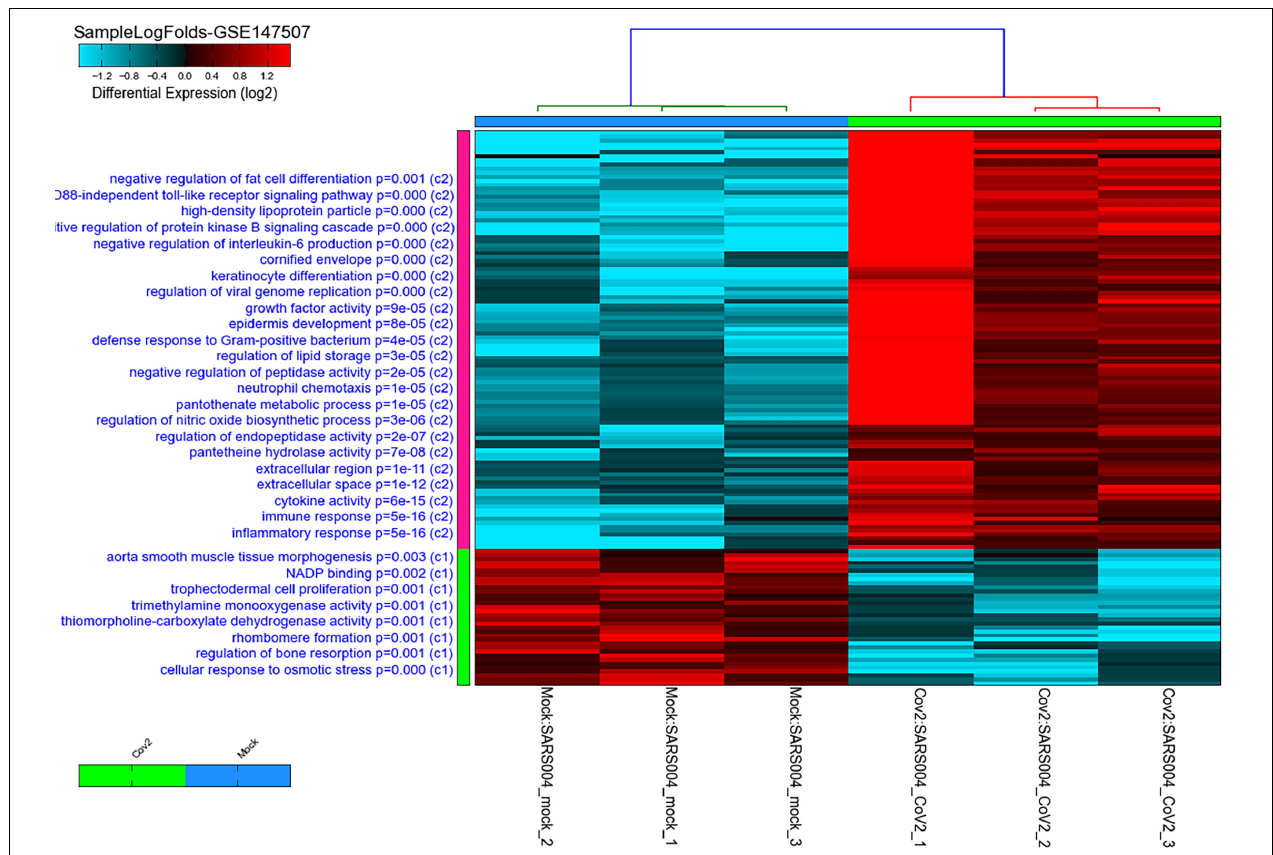
FIGURE 1 | Heatmap and clustering of SARS-CoV-2 infected healthy epithelial cells versus non-infected (mock-infected cells) using GSE147507 publicly available transcriptomics dataset. Pathways, where the DEGs are involved, are shown on the right side of the heatmap with their adjusted p -value. The C1 represent pathways of genes downregulated in infected cells, while C2 represent pathways of genes upregulated when cells are infected compared to mock-infected cells.